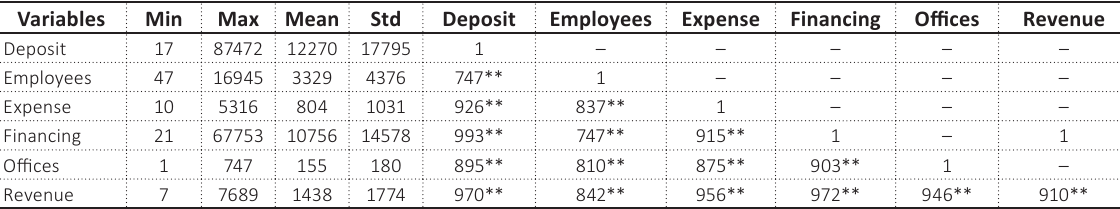
Table 2. Correlation and descriptive variables